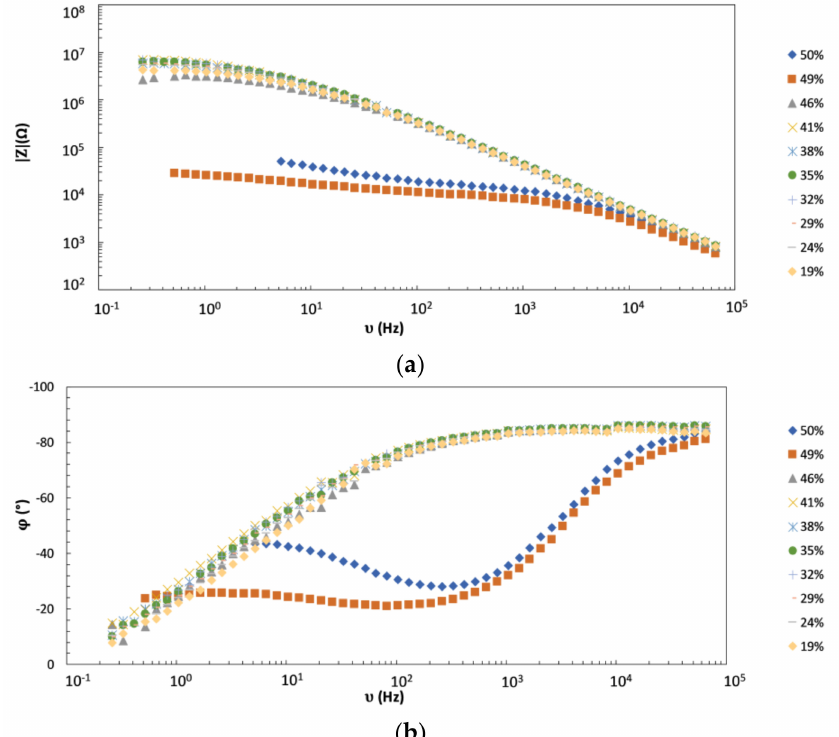
Figure 2. ( a ) Modulus and ( b ) phase angle (Bode diagrams) of the waterborne (WB) talc coatings with various PVC values after 24 h of curing time at room